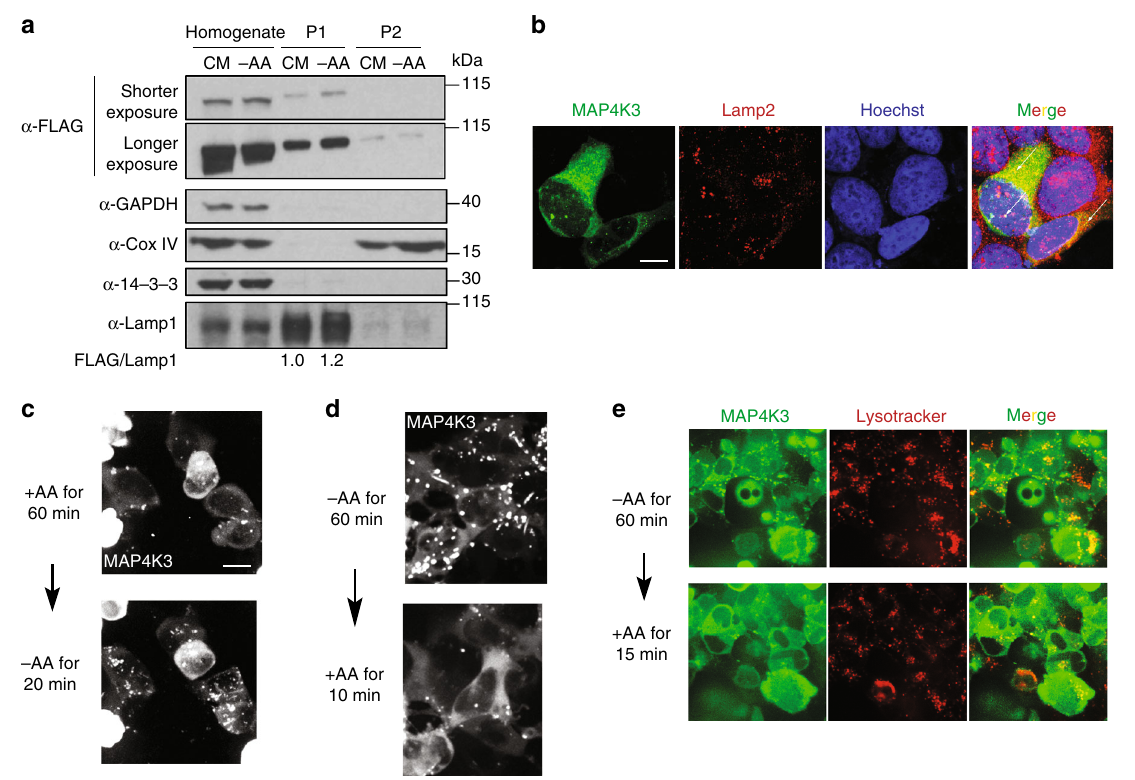
Fig. 7 MAP4K3 exhibits lysosomal localization. a HEK293A cells were transfected with FLAG-tagged MAP4K3 for 16 h, then cultured in complete media (CM) or subjected to amino acid starvation ( – AA) for 1 h. Cells were subjected to subcellular organelle fractionation via sucrose gradient density ultracentrifugation. The whole homogenate and isolated lysosomal fractions (P1 or P2) were collected for immunoblotting analysis, as indicated. Densitometry of MAP4K3 and Lamp1 was performed on the immunoblot of the P1 lysosomal fraction to quantify MAP4K3 in the lysosomal fraction, normalized to Lamp1. The relative ratio of MAP4K3 in the P1 fraction for CM-cultured HEK293A cells and amino-acid starved HEK293A cells is given below their respective lanes, with MAP4K3 in CM-cultured HEK293A cells arbitrarily set to 1. b HEK293A cells were transfected with MAP4K3-mNeonGreen and maintained under conditions of amino acid satiety for at least 60 min, before being switched to media lacking amino acids for 60 min, after which cells were fi xed and immunostained for Lamp2. Note numerous puncta (arrows indicate representative examples) revealing colocalization of MAP4K3 with Lamp2. Scale bar = 10 μ m. c HEK293A cells were transfected with MAP4K3-mNeonGreen and maintained under conditions of amino acid satiety for at least 60 min, before being switched to media lacking amino acids. Note the marked increase in MAP4K3 localization to cytosolic puncta upon amino acid starvation. Scale bar = 10 μ m (see Supplementary Movie 1 for live cell imaging). d HEK293A cells were transfected with MAP4K3-mNeonGreen and starved of amino acids for 60 min, before being switched to amino acid-replete media. Note the MAP4K3 disassociation from cytosolic puncta to diffuse cytosolic localization upon supplying amino acids. Scale bar = 10 μ m. e HEK293A cells were transfected with MAP4K3-mNeonGreen, treated with Lysotracker Red, and starved of amino acids for 60 min, before being switched to amino acid-replete media. Note the prominent MAP4K3 colocalization with Lysotracker Red in cytosolic puncta during amino acid starvation, then upon amino acid supplementation, and MAP4K3 movement from cytosolic puncta